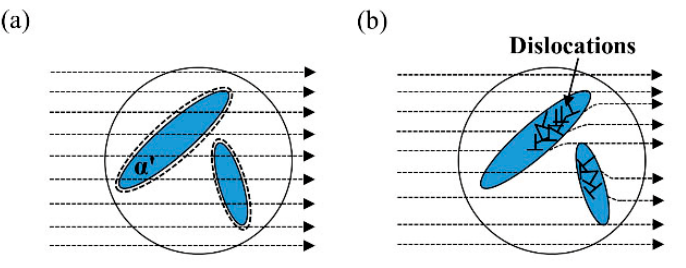
Figure 11. Schematic diagram of the current line distribution when an electric current pass through.